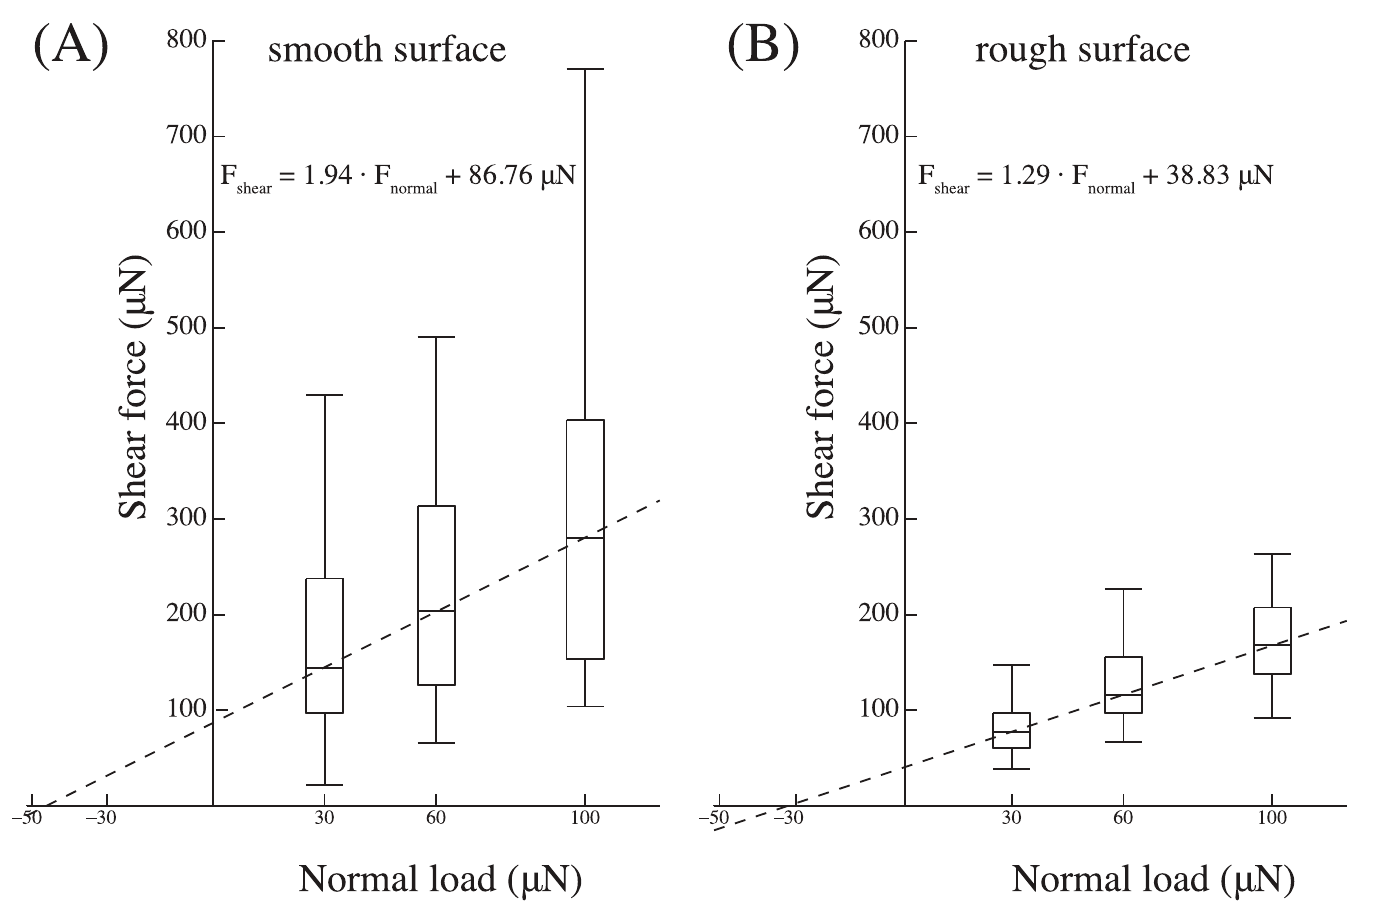
Fig 7. Friction forces of tarsal hairs in the pushing direction. (A) on a smooth and (B) on a rough surface for varying normal preloads (30, 60 and 100 μ N). The dashed lines show the results of a linear regression on the median for each normal force